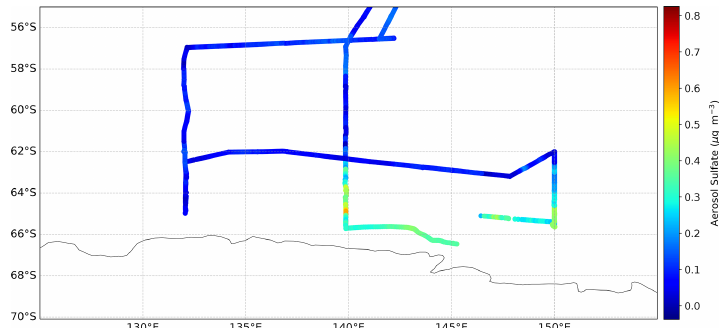
Figure A8. Voyage map from CAPRICORN2 showing the concentration of sulfate aerosol as measured by the ToF-ACSM as an indicator of the crossing of the Atmospheric Compositional Front of